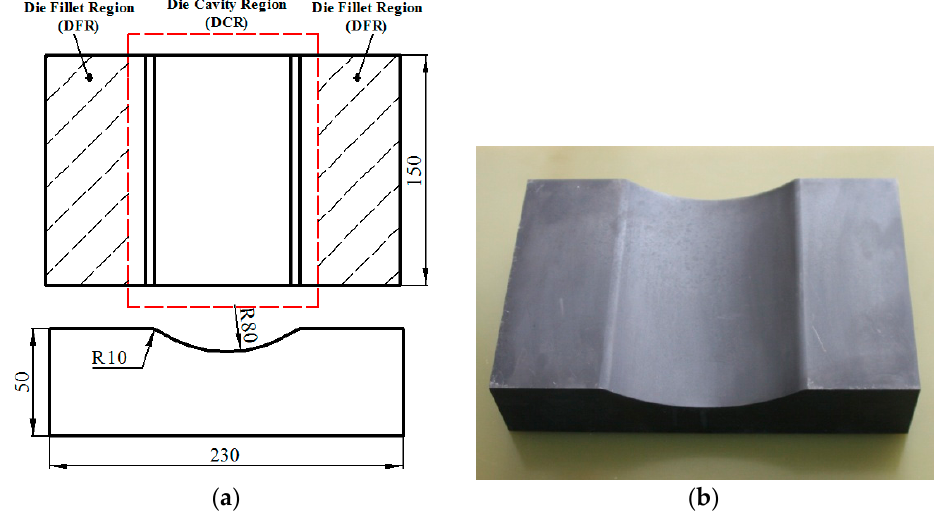
Figure 2. The sketch of the die: ( a ) sizes (mm); and ( b ) experimental photo.